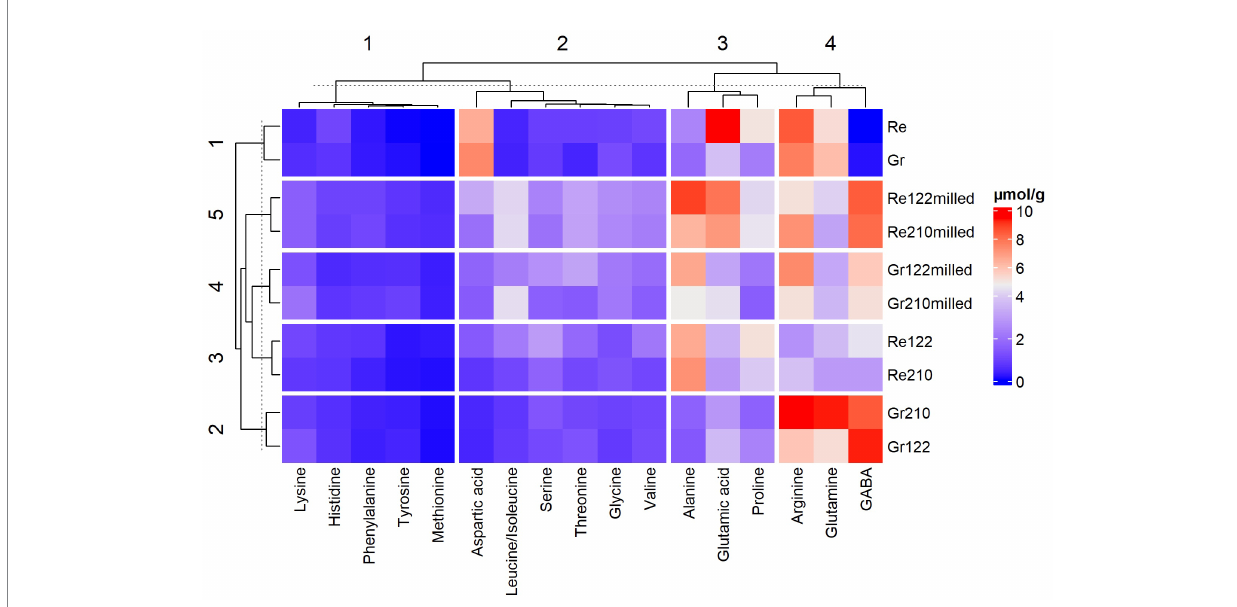
FIGURE 2 Gamma-aminobutyric acid (GABA) and free amino acid (FAA) content in lentil samples (Re—non-treated red lentils; Gr—non-treated green lentils; 122 —fermented with Lactiplantibacillus plantarum strain; 210 —fermented with Lacticaseibacillus casei strain; milled —milled